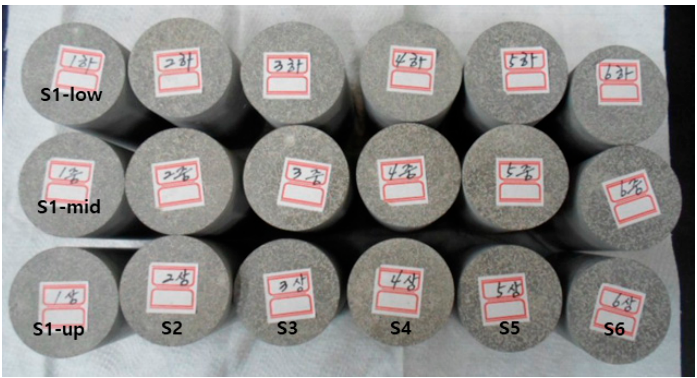
Figure 3. Image of polished representative samples collected from waste-form drums.